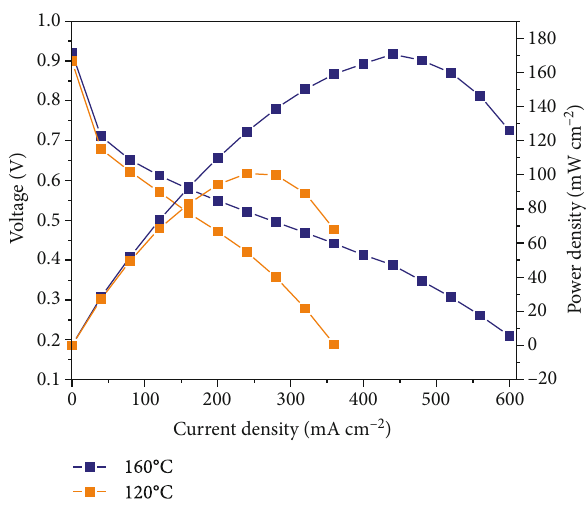
Figure 7: Single cell performance of PA-doped PEI-ER(1:2)/PBI at 120 ° C and 160 °